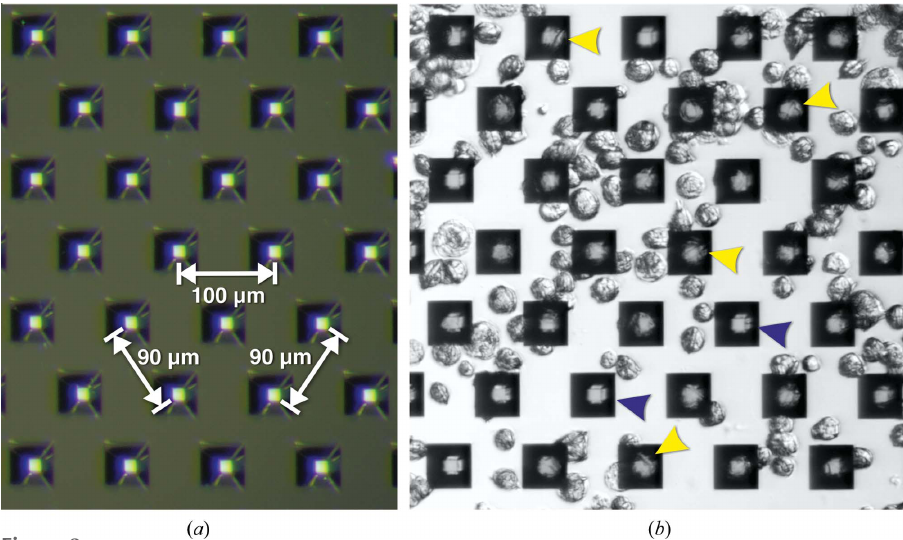
Figure 2 ( a ) An empty micro-patterned silicon chip designed for the Roadrunner II goniometer. The chip contains 12 m m sized pores that are spaced 90 and 100 m m apart, allowing well defined positioning of crystal- containing cells. ( b ) Sf9 insect cells containing in cellulo grown HEX-1 crystals were sucked into the chip pores. Visible intracellular crystals positioned in the pores are marked with yellow arrows; blue arrows point into empty pores. The images were recorded using reflected light on an Olympus SZX16